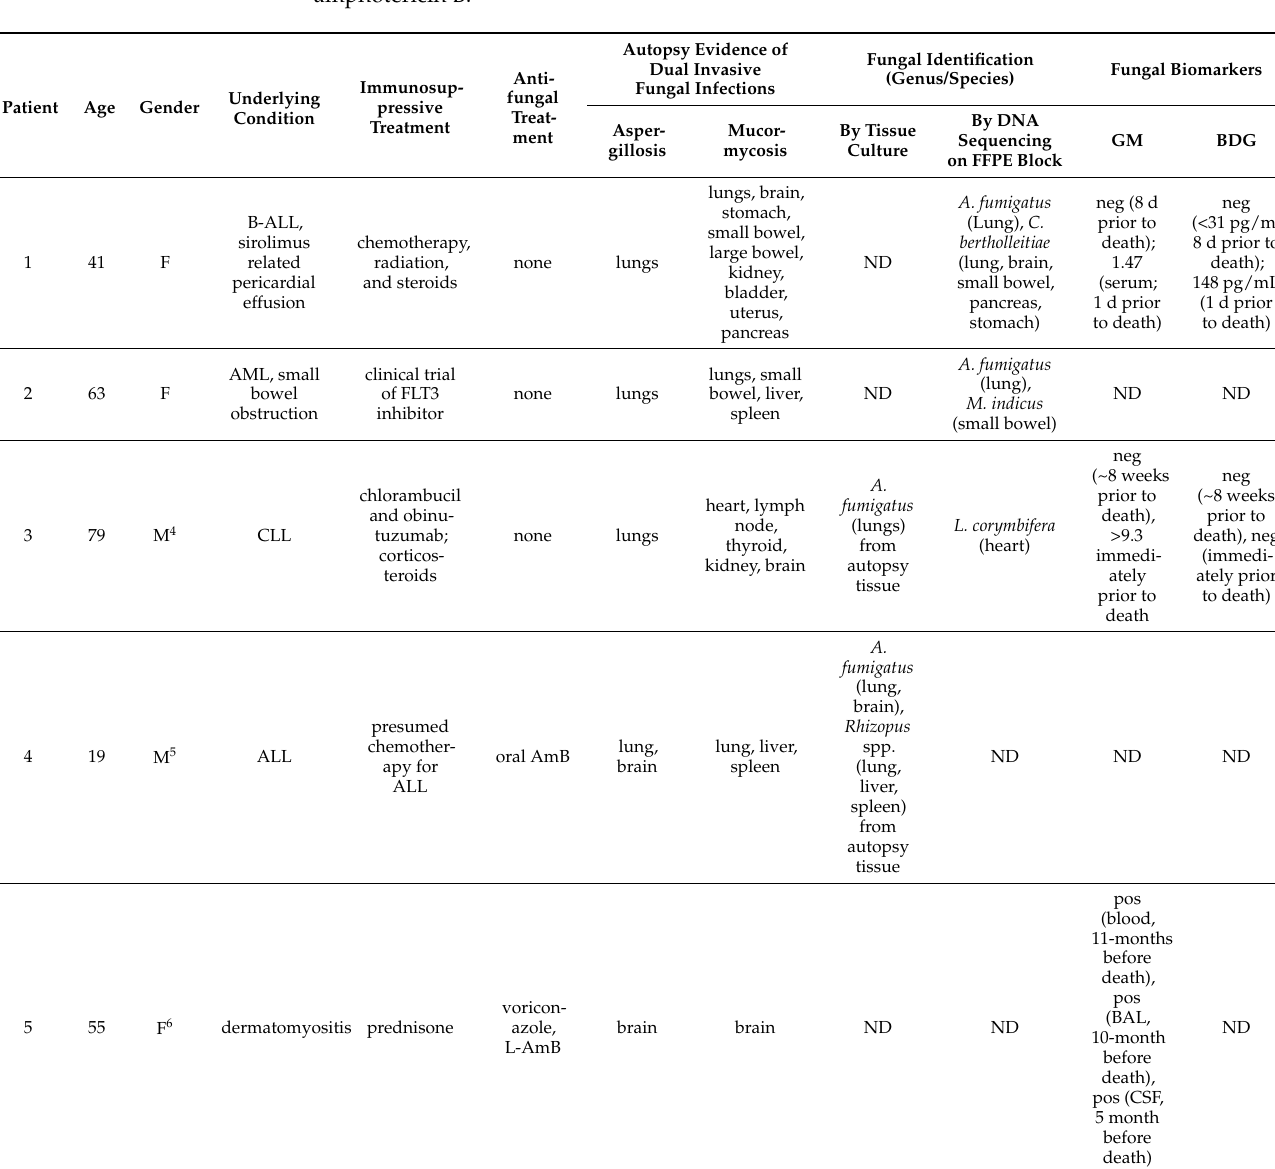
Table 1. A literature review was performed by searching PubMed for combinations of Aspergillus / aspergillosis, Mucor /Mucorales/mucormycosis, and mixed mycosis, mixed mycotic infection, coin- fection or dual infection to identify relevant papers in English. Cases referenced in the papers initially retrieved were also collected. Over 70 reported cases of Aspergillus and Mucorales coinfection were identified in this manner. Cases were excluded from the table based on (1) if the patient